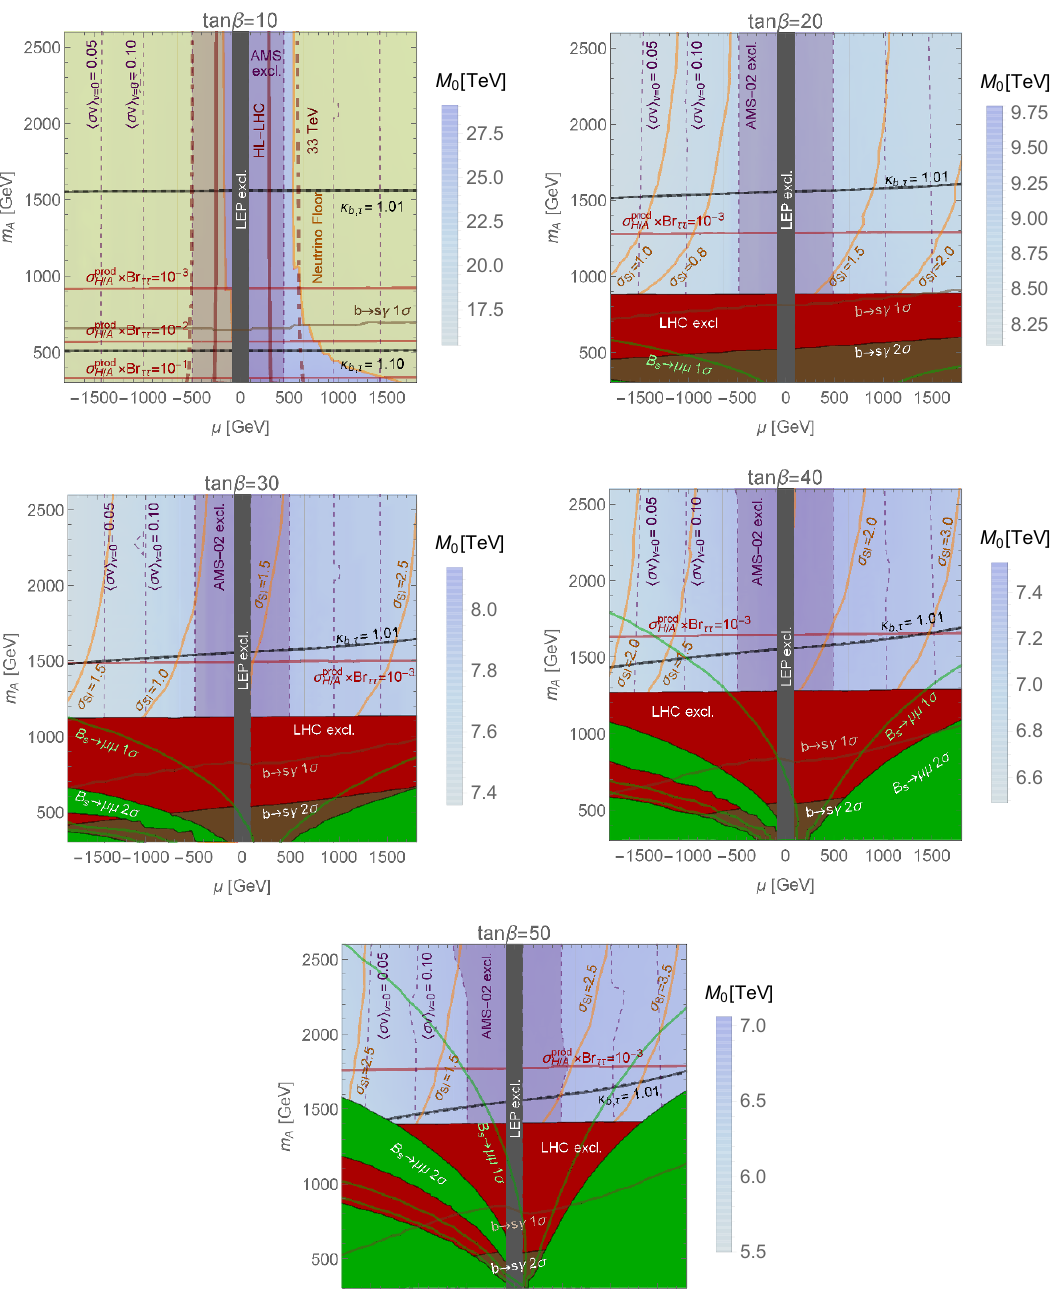
Figure 3 . Values of the observables in the case tan (cid:12) = 10 ; 20 ; 30 ; 40 ; 50. The meaning of the each line is the same as in (cid:12)gure 2. The gray and purple regions are excluded by the LEP experiment and the AMS-02 experiment. The purple dashed lines show the annihilation cross section in the unit of (cid:2) 10 (cid:0) 25 cm 3 = s.